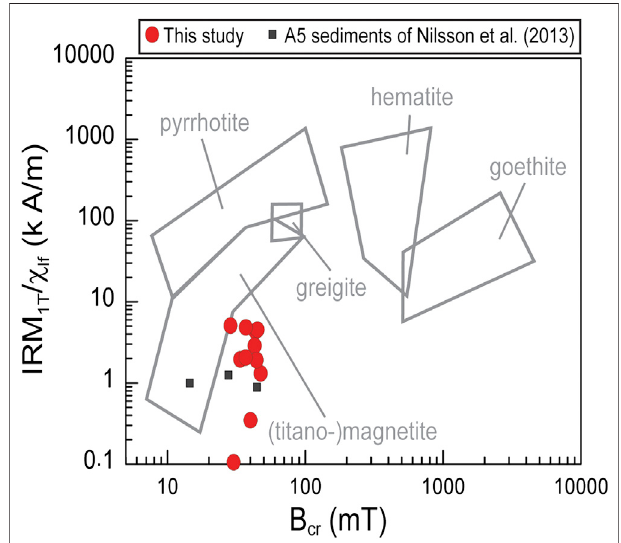
FIGURE 9 | Biplot of IRM 1T / χ lf vs. B cr for the YAR-4 core sediments (red circles; n (cid:1) 11),withtypicalranges(grayboxes)ofthemagneticparametersfor different minerals proposed by Peters and Thompson (1998) and data for the A5 sediments reported by Nilsson et al. (2013) (black squares).